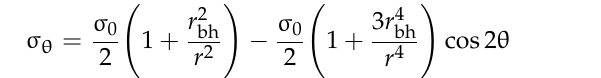
Figure 7. Relation between NC ( ∆ σ )